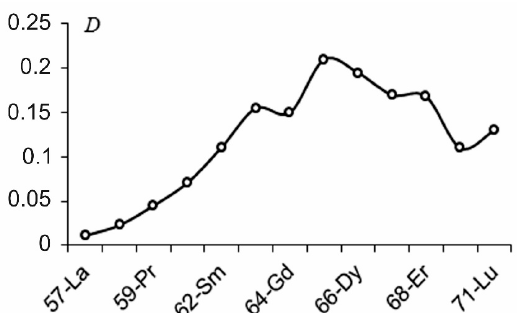
Figure 3. REM distribution coefficient (D) when extracting by TBP from nitrate weak-acid solutions [31].